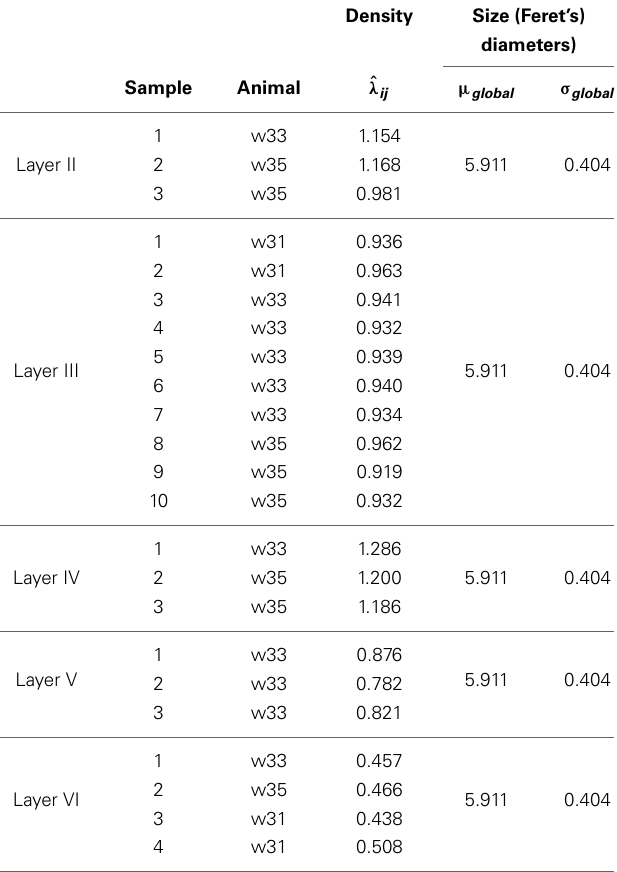
Table 3 | Estimated intensity ˆ λ ij for samples in layer II to VI using only the remaining samples of the same layer [Equation